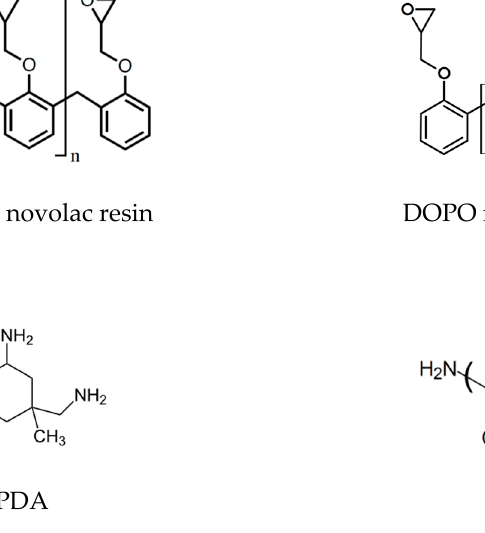
Figure 1. Chemical structure of the epoxy novolac resin system (DOPO modification is highlighted red) and the hardener (blend ratio 50:50 parts by weight).